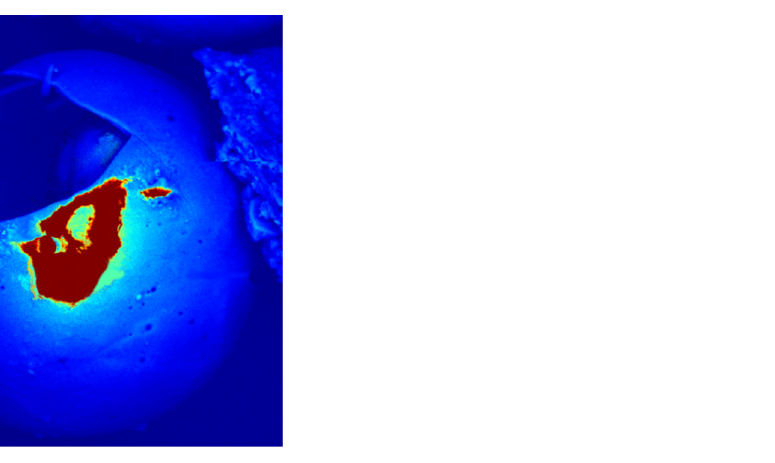
Figure 4. SEM microphotographs of the CS fraction F_212 (energy: 20 keV): ( A ) SE mode, ( B ) BSE mode.